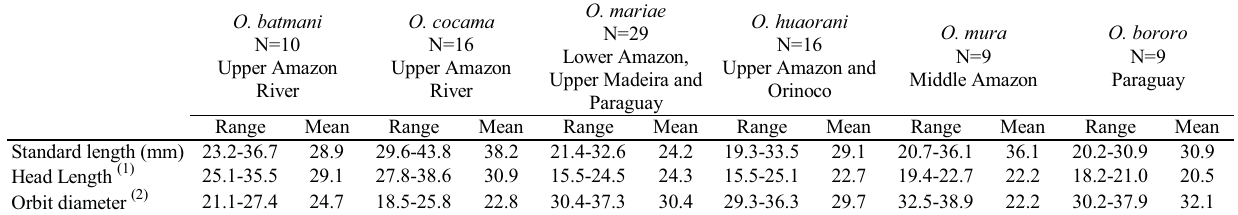
Table 1. Diagnostic morphometric data of Otocinclus batmani compared with closest congeners. Values for O. mariae , O. huaorani , O. mura , and O. bororo from Schaefer (1997), and for O. cocama from Reis (2004). (1) Percent of standard length; (2) percent of head